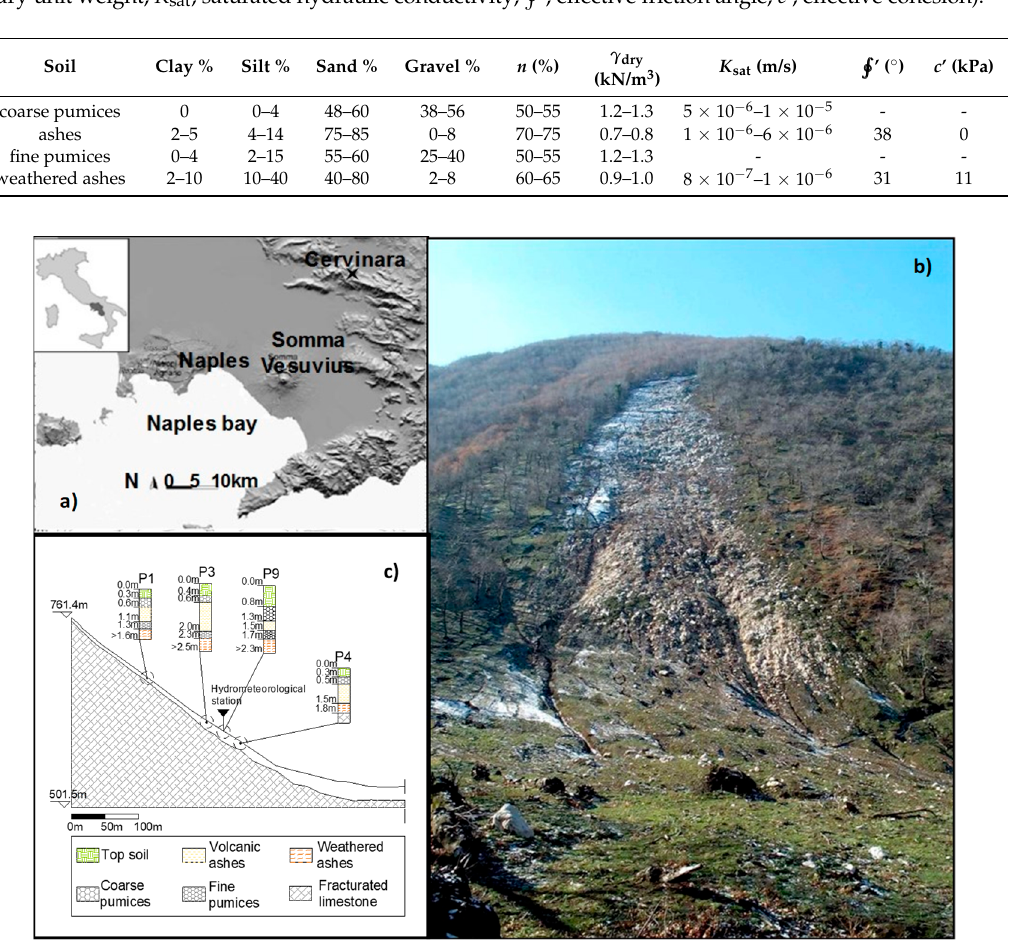
Table 1. Main physical characteristics of the pyroclastic soils of the cover of Cervinara ( n , total porosity; γ dry , dry unit weight; K sat , saturated hydraulic conductivity; ф ’, effective friction angle; c ’, effective cohesion).